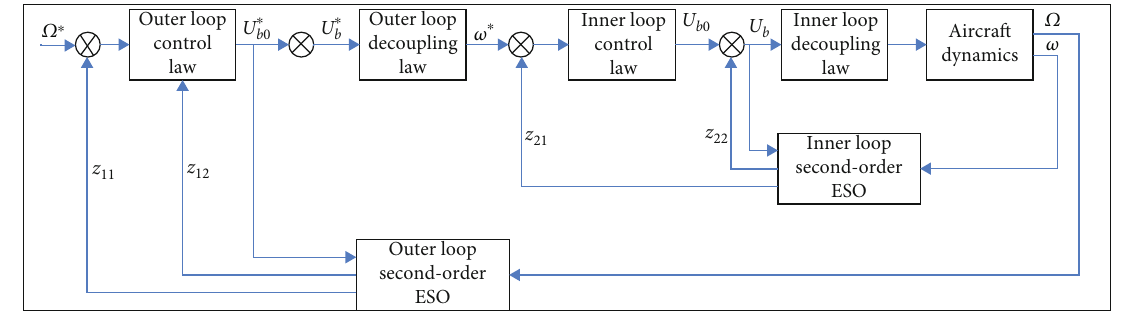
Figure 1: The diagram of a dual-loop attitude controller based on